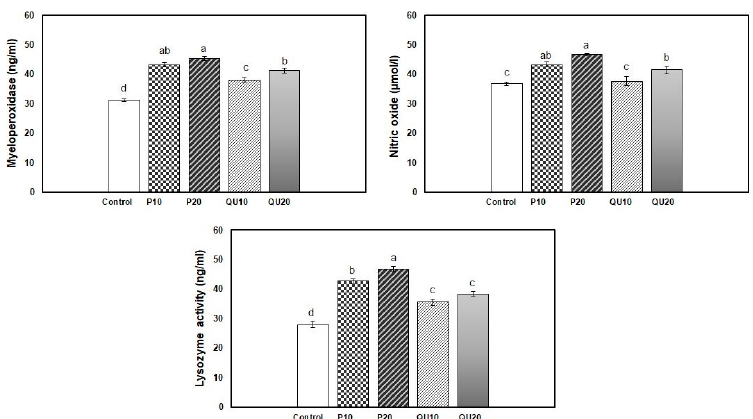
Figure 3. Effect of PP or QU supplementation at different levels (10% and 20%) for 45 days on the immune status variables in Nile tilapia. Values are expressed as mean ± SE ( n = 6/group), and the values not sharing a common superscript letter differ significantly at p < 0.05 by one-way ANOVA followed by Tukey’s B post hoc test. PP 10 : prickly pear fruit peel-supplemented group (10%), PP 20 : prickly pear fruit peel-supplemented group (20%), QU 10 : quinoa seeds—supplemented group (10%), QU 20 : quinoa seeds—supplemented group (20%). 3.6. Gene expression Patterns of Immune-Encoding Genes in Nile Tilapia in Response to Dietary Supplementation with PP or QU In the spleen of fish from the supplemented groups, the transcription of the TGF- β gene was significantly upregulated upon the dietary supplementation with PP 20 , followed by PP 10 and QU 20 (4.01, 2.71, and 2.57-fold, respectively) ( p = 0.001). The level of transcription of this gene was statistically similar in the PP 10 and QU 20 -supplemented groups. The QU 10 -supplemented group